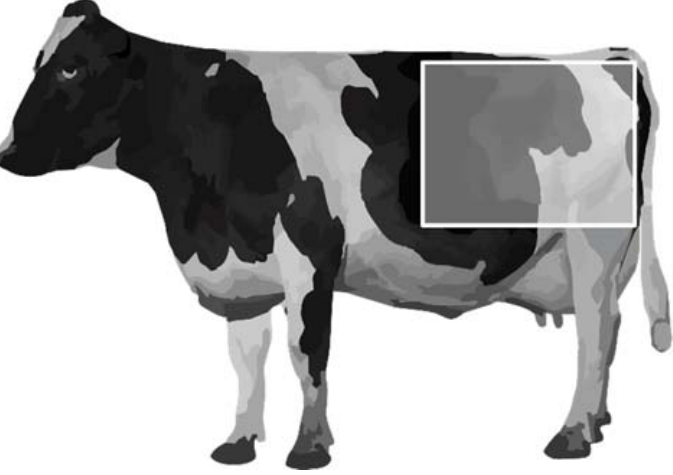
Figure 1. Site from which the hair samples were derived. Only clean, white hairs were collected.